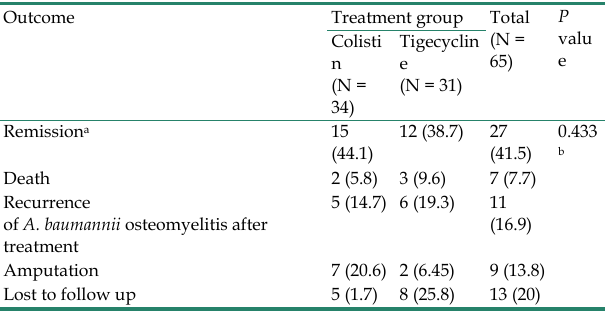
Table 3 . Distribution of the outcomes observed after 12 months of treatment according to the antimicrobial used